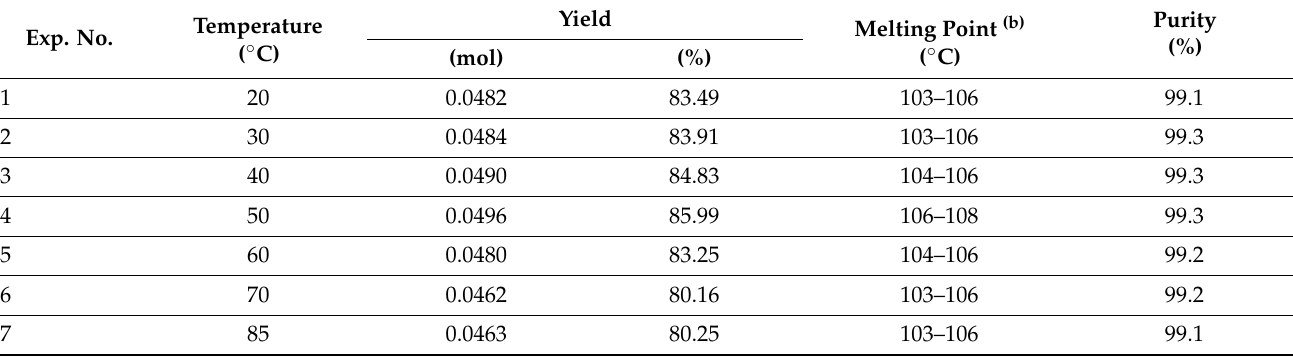
Table 1. The yield of TMTS as a function of the reaction temperature (a) .